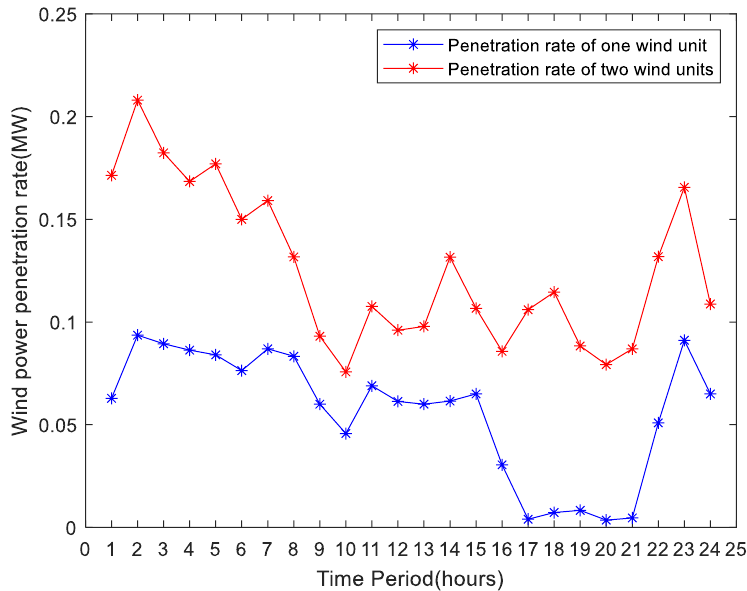
Figure 5. Permeability of wind power at different time periods.